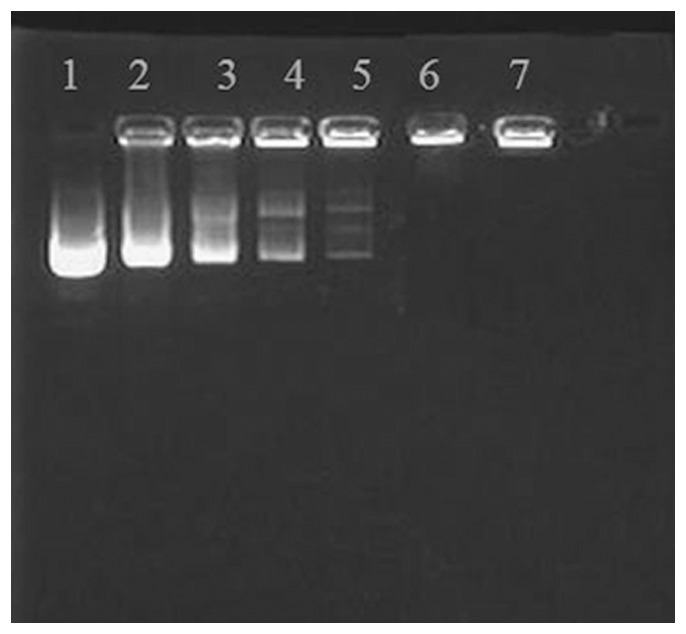
Agarose gel electrophoresis of the pDNA/pSP-CS complexes.Lane 1: free plasmid DNA; lane 2–7: pDNA:pSP-CS (w/w)  = 1:0.25; 1:0.5; 1:0.75; 1:1; 1:1.5; 1:2. When pDNA:pSP-CS reached 1:1.5, these complexes lost their mobility in the gel.